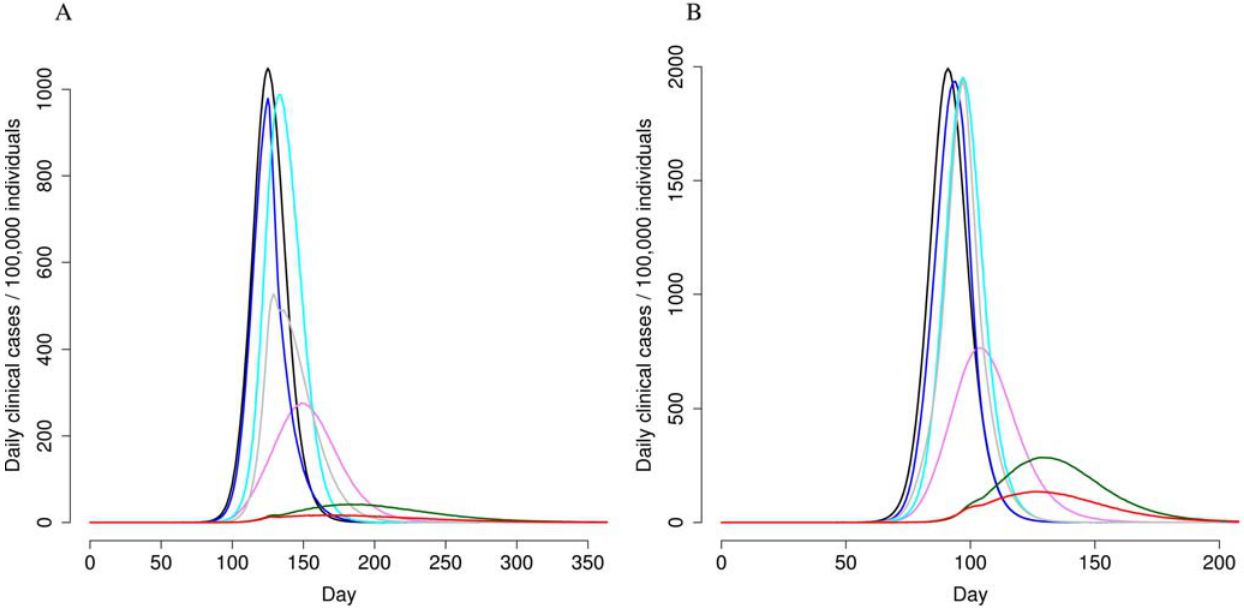
Figure 3. Clinical AR, by control measure and scenario (Panel A: R 0 =1.7; Panel B: R 0 =2). black=baseline results; light blue= 90% air travel restriction; violet=AVP to household contacts; blue=vaccination, administering first dose within 3 months of the first world case for R 0 =1.7, or within 2 months for R 0 =2; grey=90% air travel restriction + vaccination, as reported for the blue line; green=all control measures combined; red=all control measures combined, extending AVP to school/work close